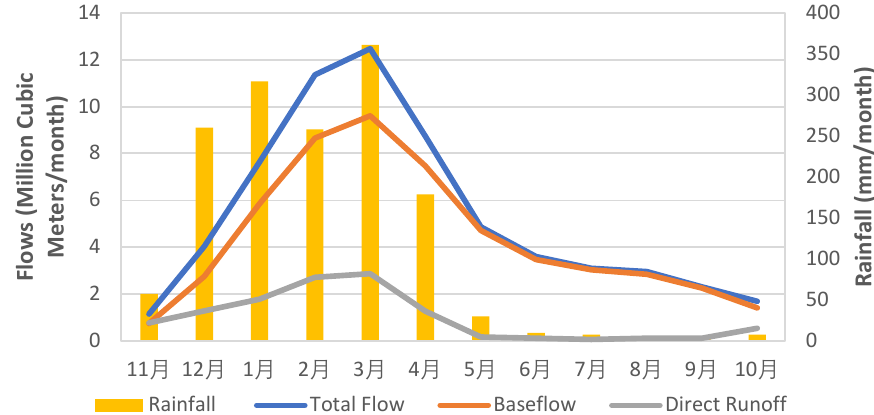
Figure 3. Average monthly flow volumes (total flow, baseflow, direct runoff), for the Bua River, Gauge